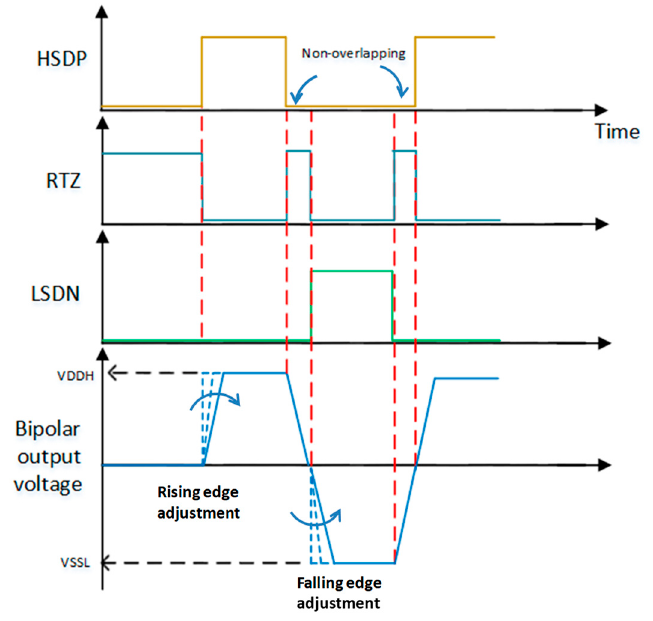
Figure 8. The schematic of the output pulse sequences and the rising/falling edge adjustment.